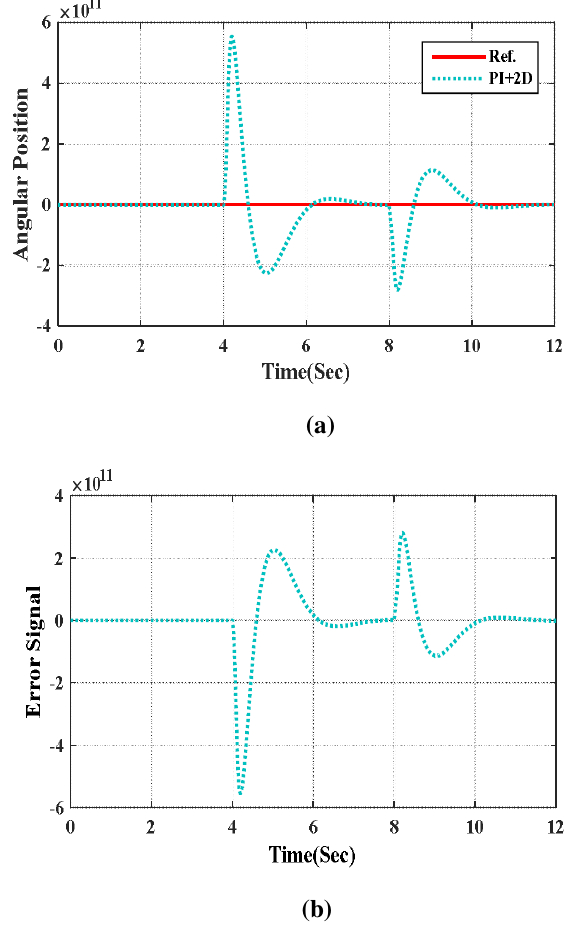
Fig. 13. Simulation results for robotic leg controlled with PI+2D and multi-step input of mag.2: (a) angular position, (b) error signal